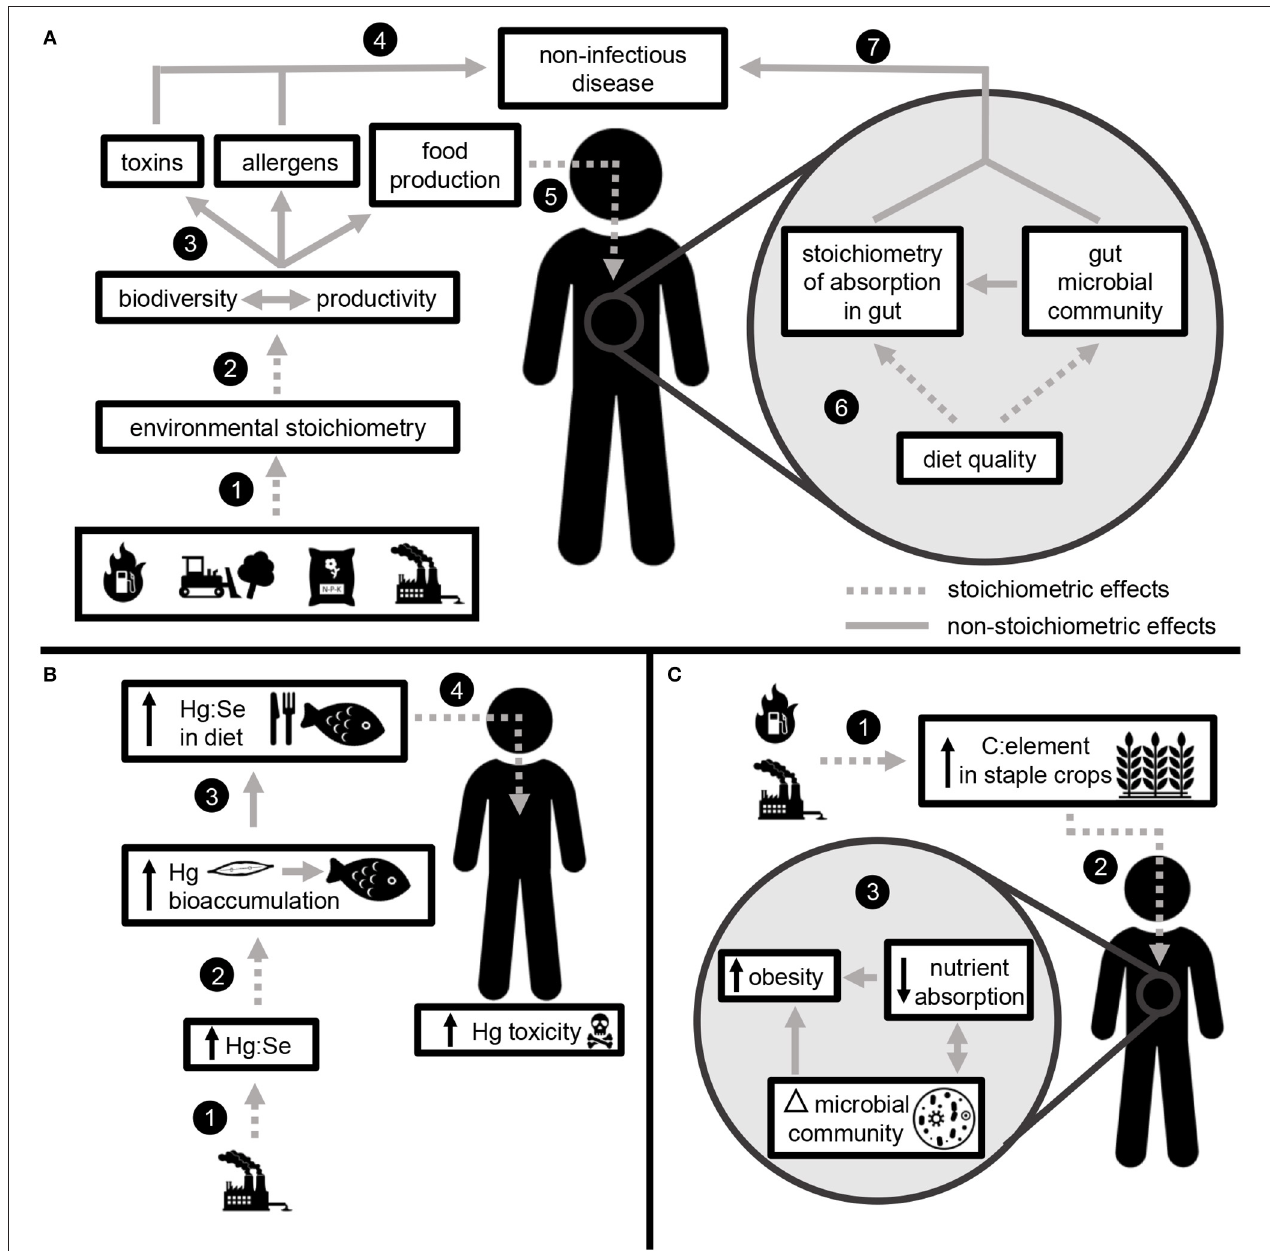
FIGURE 3 | Elemental ratios link global change with non-infectious disease through stoichiometric effects occurring in the environment and within the human body. (A) Fossil fuel combustion, land use change, fertilizer application, and industrial pollution change the relative availability of elements in the environment (1). Environmental stoichiometry impacts the key ecosystem processes of biodiversity and productivity (2), both of which contribute to the production of toxins, allergens, and food (3). Allergens and toxins directly contribute to non-infectious disease (4), while the effects of food quality are mediated by stoichiometric effects within the body (5). Elemental ratios in human diet impact the efficiency of nutrient absorption and the structure and function of the gut microbiome (6), both of which mediate the effects of nutrition on non-infectious disease (7). (B) Example: Industrial production increases the concentrations of Hg in the environment, which leads to higher Hg:Se (1). The degree to which Hg bioaccumulates in aquatic organisms is mediated by Hg:Se (2), leading to greater Hg consumption through human diet (3). Following consumption, Hg:Se within the body impacts Hg toxicity (4). (C) Example: Anthropogenic increases in CO 2 lead to increased C:element in food crops (1). Elemental ratios in diet (2) may lead to shifts the gut microbiome and impact nutrient absorption, both of which contribute to obesity (3).